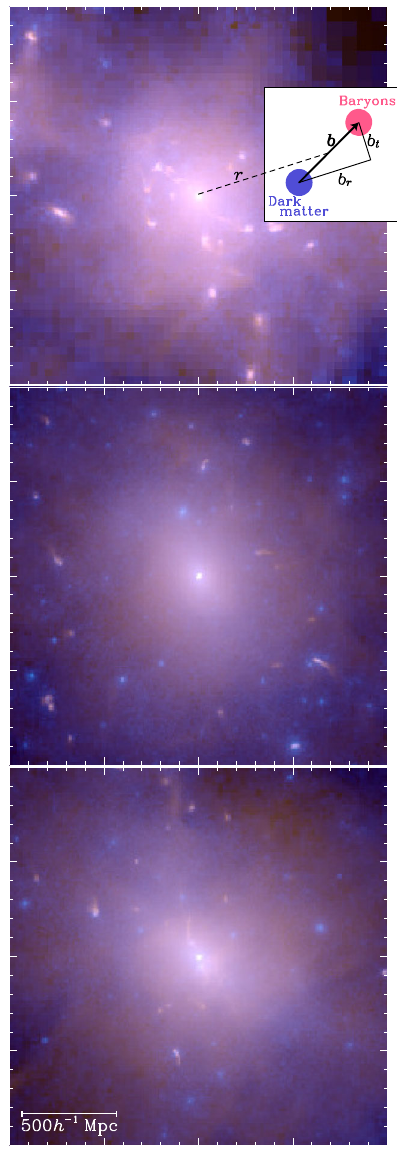
Fig. 40 Full hydrodynamical simulations of massive clusters at redshift z = 0 . 6. Total projected mass is shown in blue, while X-ray emission from baryonic gas is in red. The preferential trailing of gas due to pressure from the ICM, and its consequent separation from the non interacting dark matter, is apparent in much of the infalling